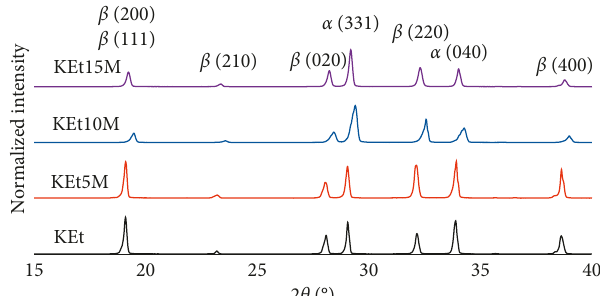
Figure 5: X-ray diffraction patterns for the KEtM series assisted in recrystallization with microwaves at 5, 10, and 15min of irradiation compared with the KEt sample without treatment.